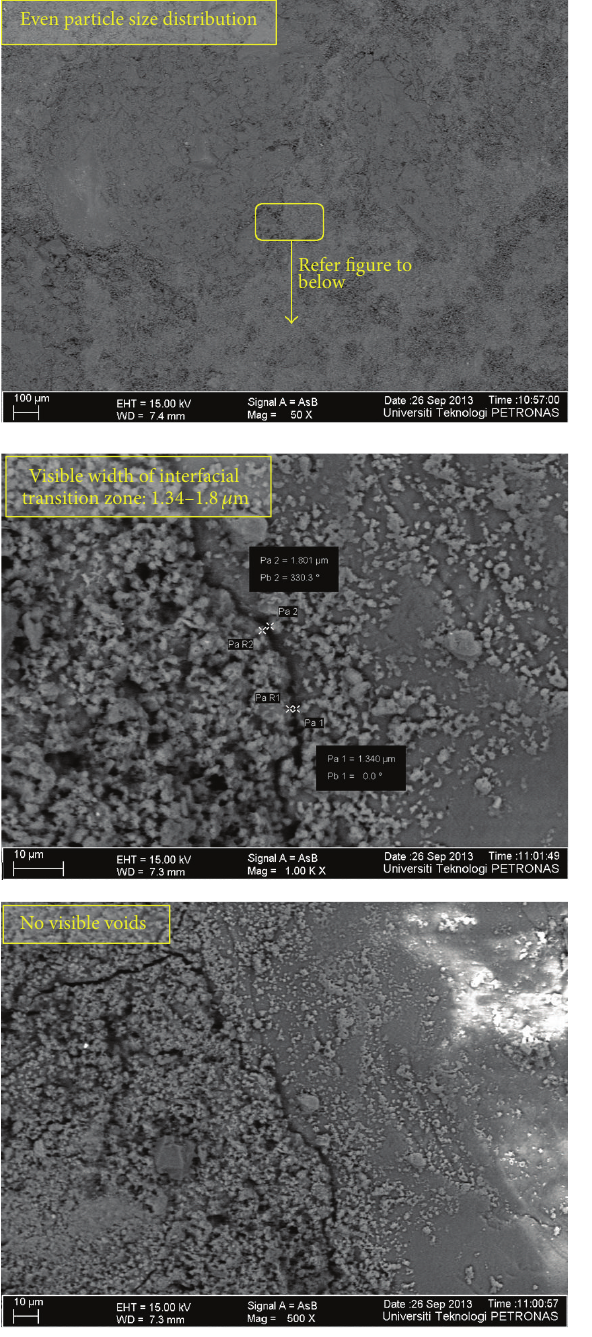
Figure 14: Microstructure of concrete mix